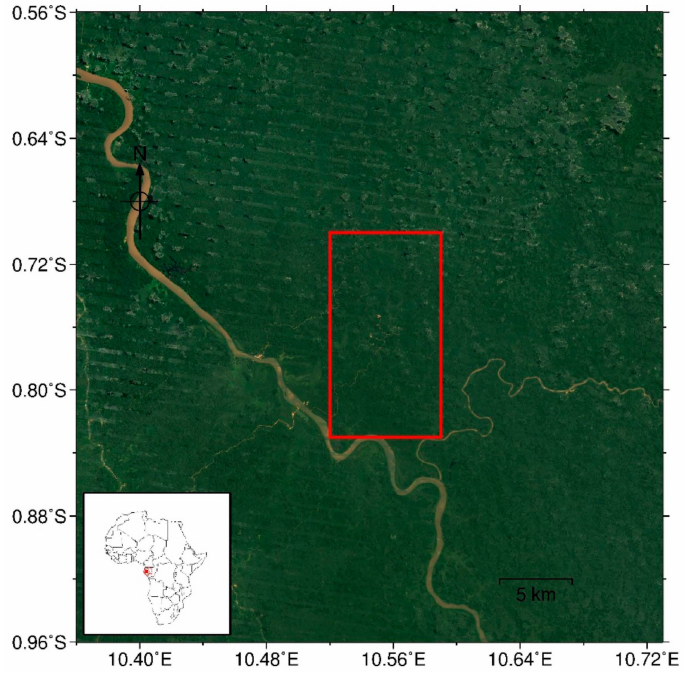
Figure 5. Geographic location of the study area marked in an optical image. The red rectangle represents the footprint of the dataset.